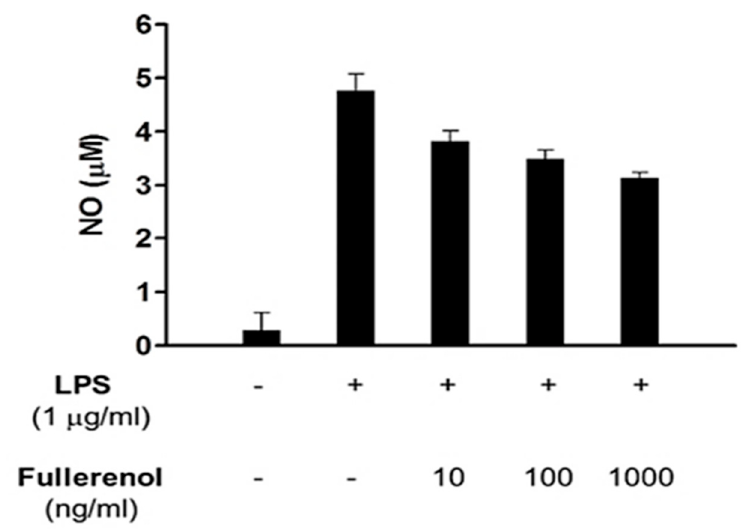
Figure 4. Dose-dependent suppression of NO production obtained after treatment with various concentrations of fullerenol in the RAW 264.7 cell cultures.